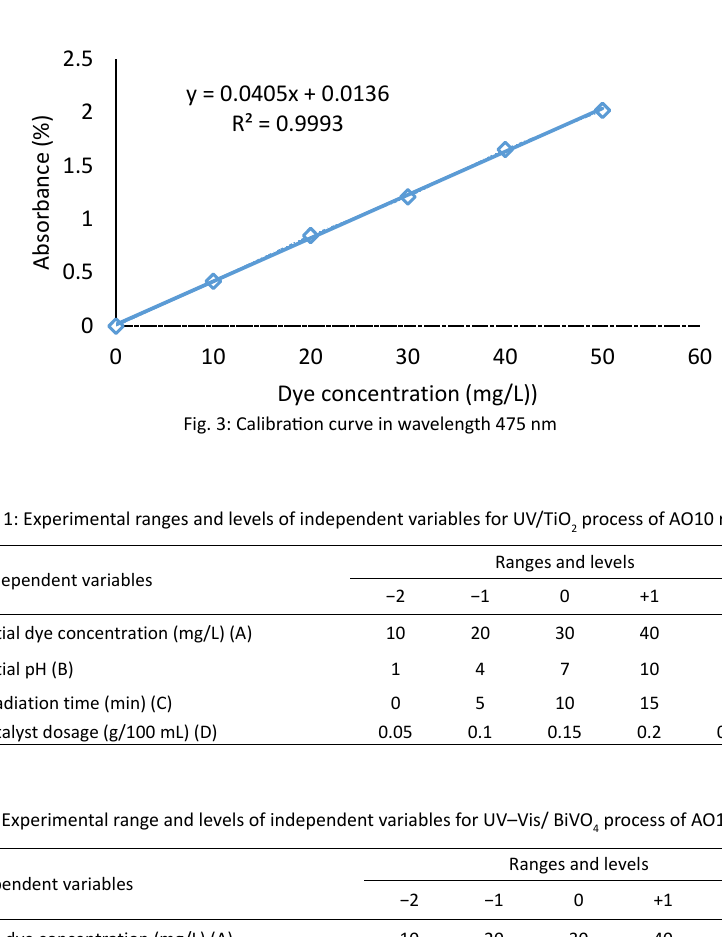
y = 0.0405x + 0.0136 R² = 0.9993